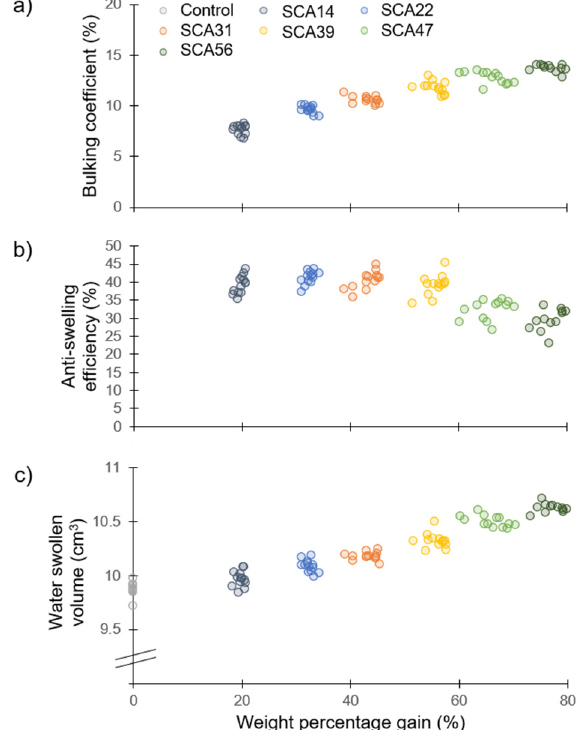
Figure 2. Dimensional changes in sorbitol citric acid modified wood as a function of weight percentage gain. ( a ) Bulking coefficient; ( b ) Anti-swelling efficiency; ( c ) Water swollen volume—note the broken y -axis.